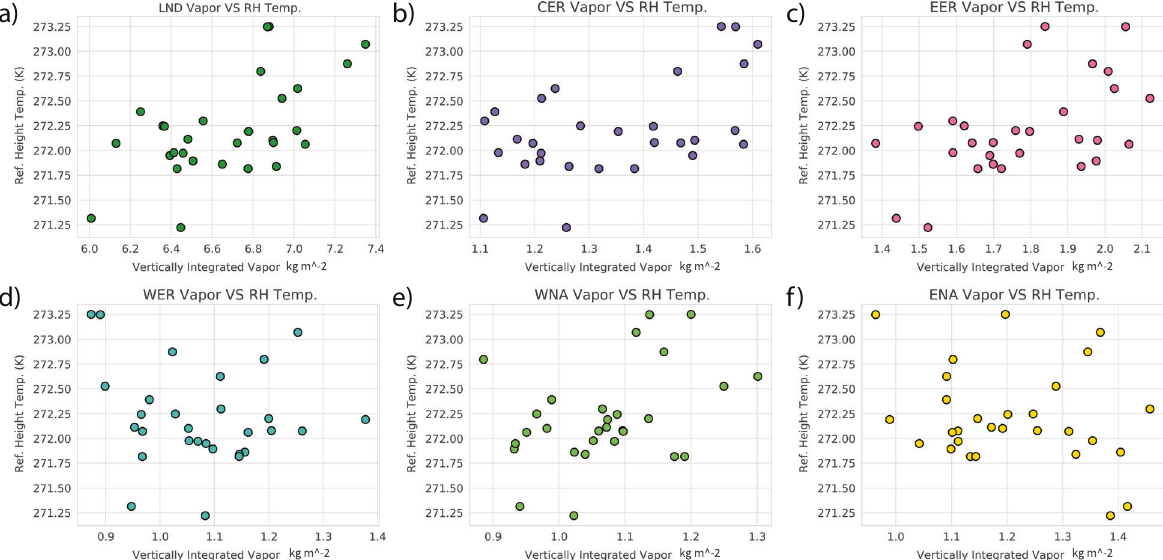
Fig. 5 Arctic near-surface temperature correlation to land vapor of different source origins. The relationship between near-surface temperatures in the Arctic and ( a ) vertically integrated land vapor and ( b – f ) vertically integrated land vapor from each longitudinally de fi ned land region (see Fig. 2). Values are area-averaged north of